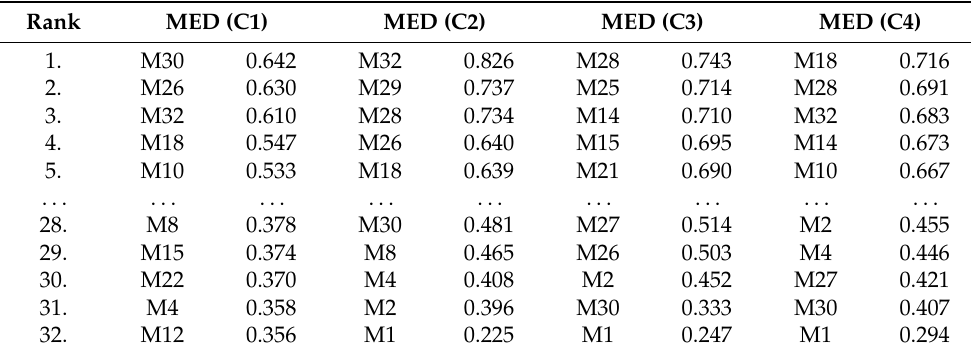
Table 8. The best- and the worst-rated municipalities within the terms of variants C1, C2, C3, and C4 throughout the entire monitored